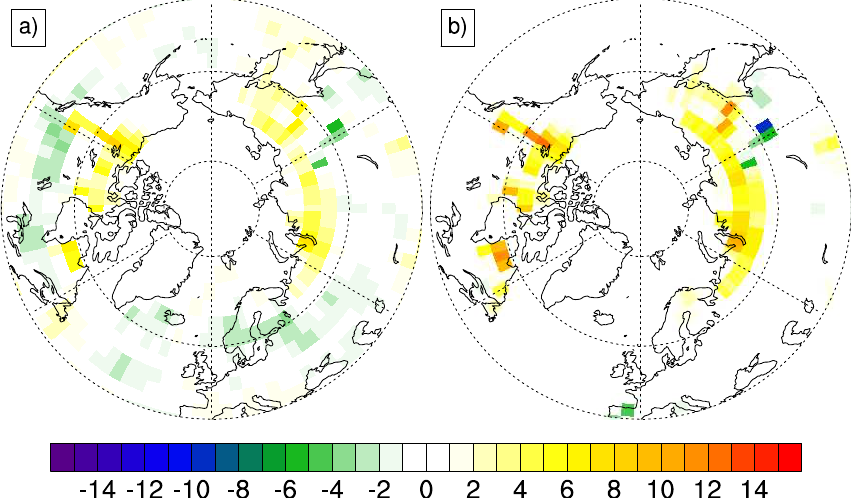
Fig. 5. Spring net surface radiation: (a) calculated spring net surface radiation δS est derived from the solar downward radiation for 0k, the change in forest fraction from 0k to 6k, and the strength of snow masking; (b) spring net surface radiation 1V w [ S ] .